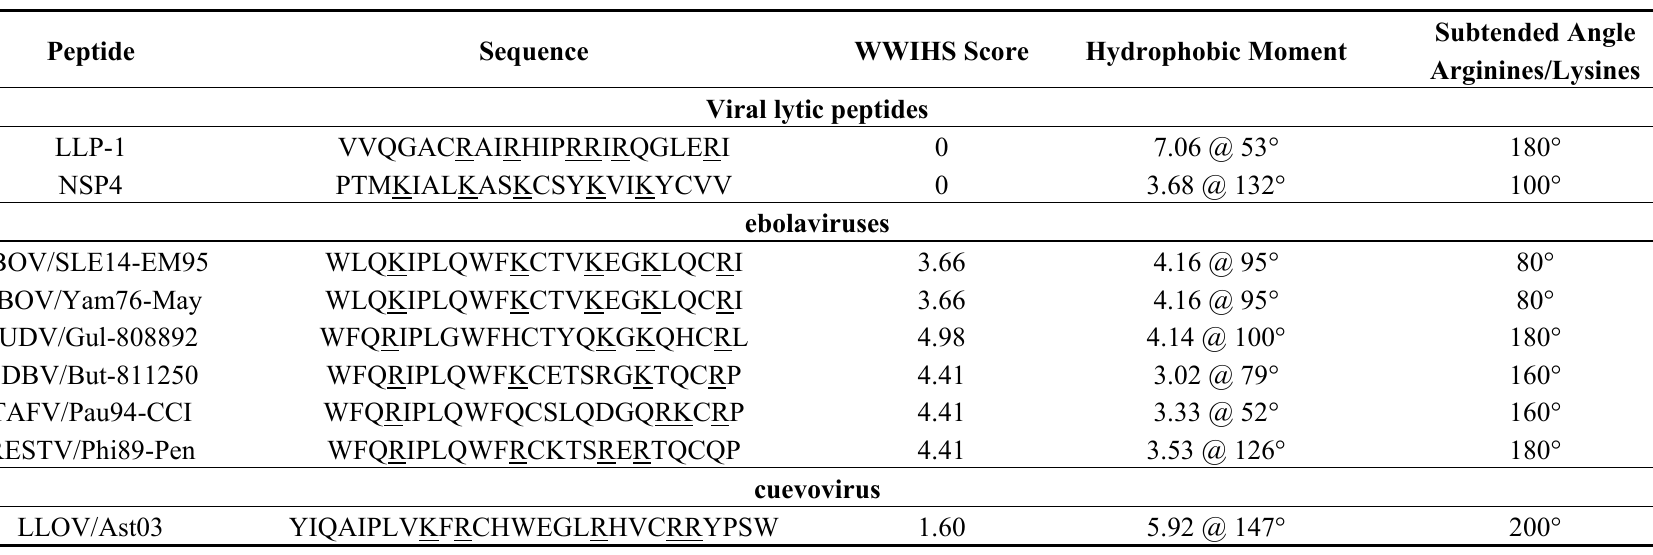
Table 3. Wimley-White interfacial hydrophobicity scale scores, hydrophobic moment, and angle subtended by arginine and lysine residues for NSP4, LLP-1, and delta peptides of ebolaviruses and cuevovirus